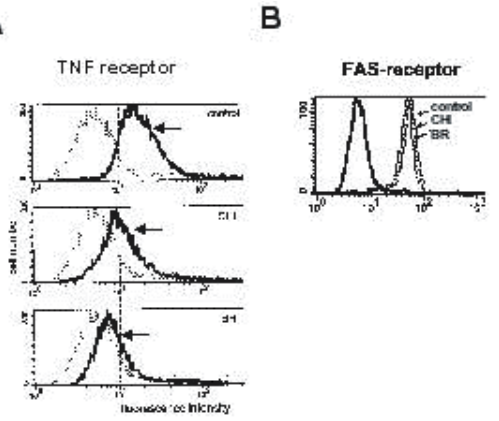
Fig. 3. The 3-hours treatment of HeLa cells with brefeldin A or cycloheximide depletes unstable TNFR molecules on cell surface (A), but does not affect presentation of stable Fas on plasma membrane